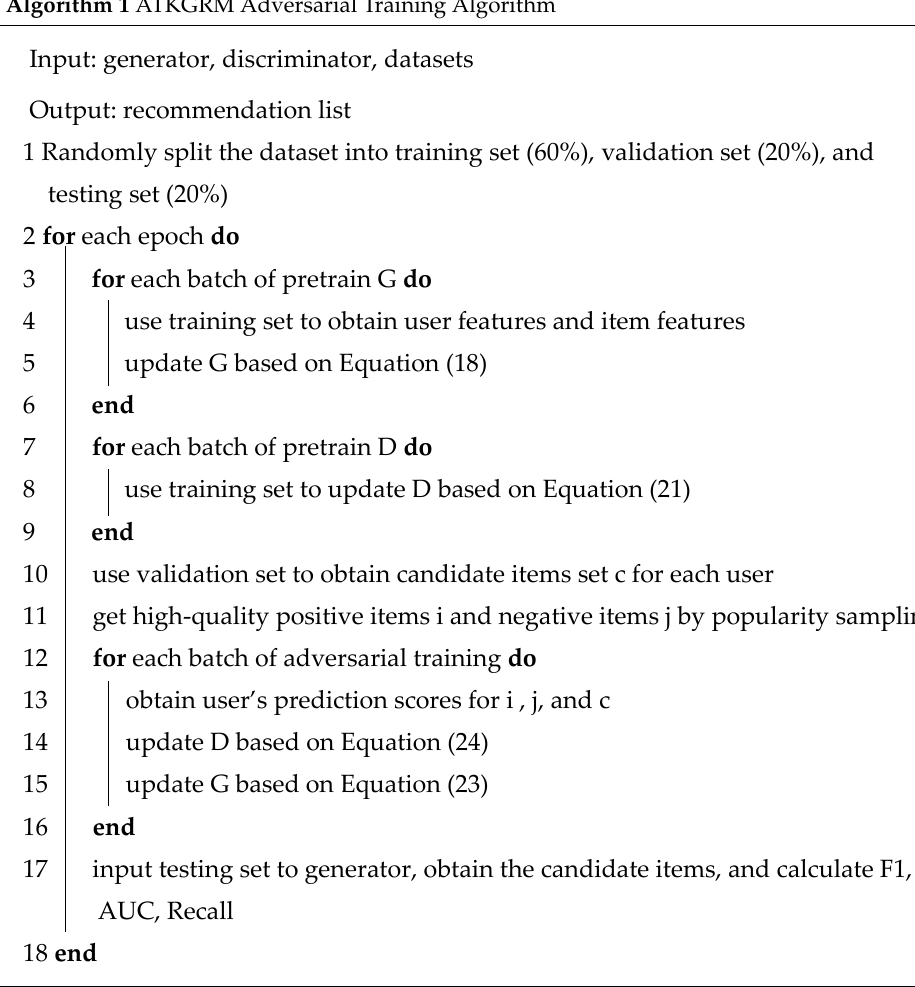
Algorithm 1 ATKGRM Adversarial Training Algorithm